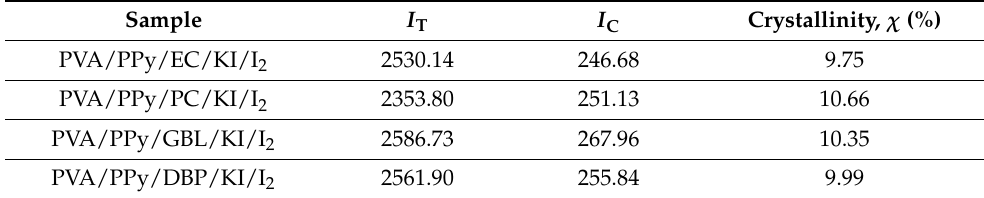
Table 1. Degree of crystallinity of the PVA/PPy/KI/I 2 electrolyte with different plasticizers.